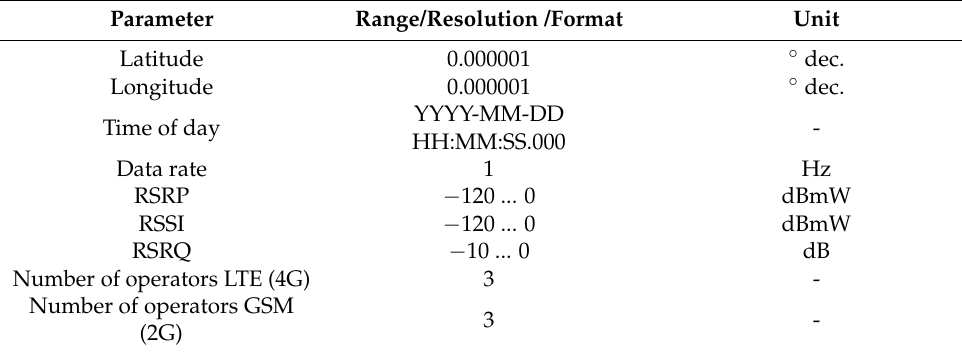
Figure 2. The antenna setup of the vehicle. Table 3. Measured parameters.